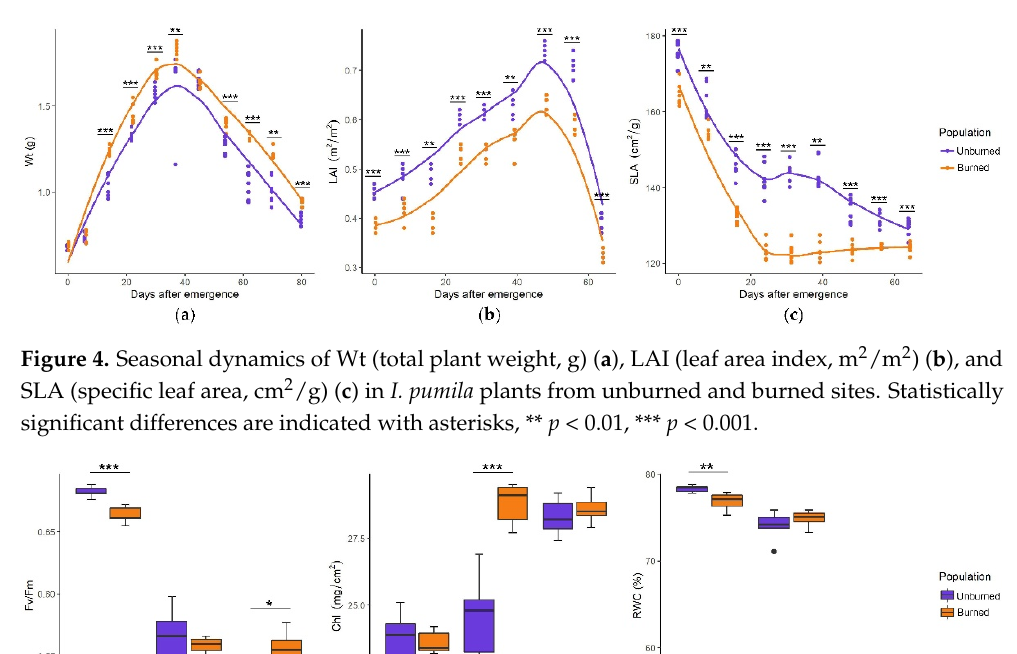
Figure 4. Seasonal dynamics of Wt (total plant weight, g) ( a ), LAI (leaf area index, m 2 /m 2 ) ( b ), and SLA (specific leaf area, cm 2 /g) ( c ) in I. pumila plants from unburned and burned sites. Statistically significant differences are indicated with asterisks, ** p < 0.01 *** p < 0.001. The seasonal dynamics of ecophysiological traits (Fv/Fm, Chl, and RWC) were simi-